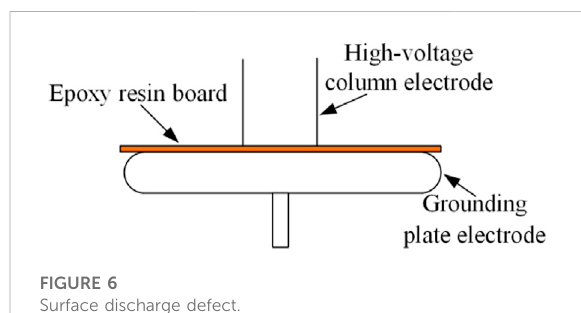
FIGURE 6 Surface discharge defect.